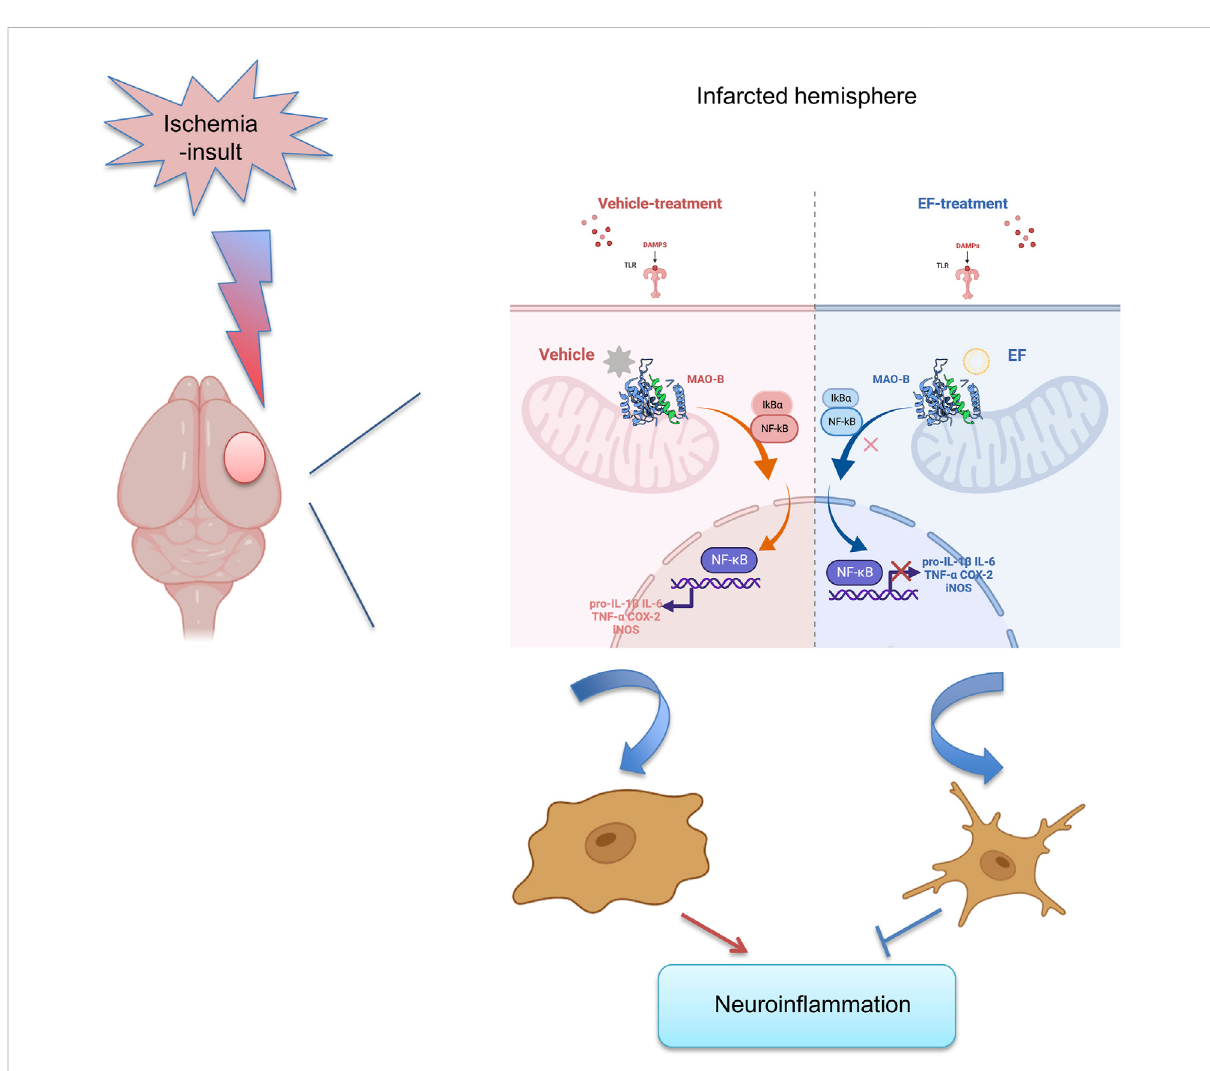
FIGURE 6 Pattern diagram of EF in suppressing neuroin fl ammation by alleviating microglial activation, reducing the expression of pro-in fl ammatory mediators including IL-1 β , IL-6, TNF- α , COX-2 and iNOS via inhibiting MAO-B activity after ischemic